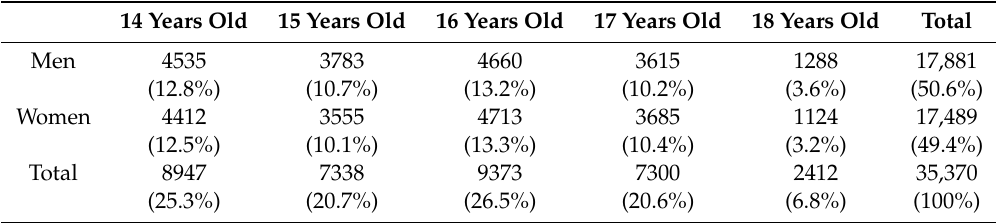
Source: authors’ own from ESTUDES 2016